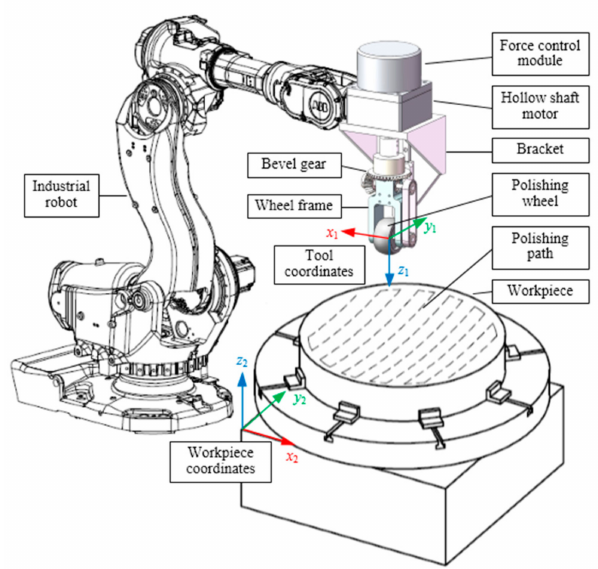
Figure 1. Structure of the